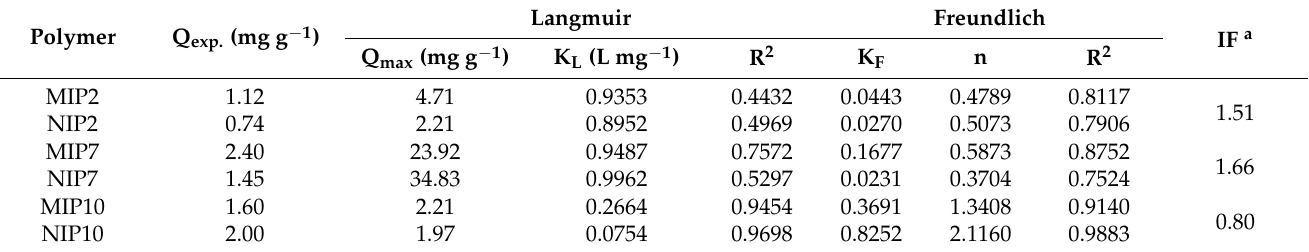
Table 2. Fitted results of adsorption data with Langmuir and Freundlich isotherm models using the non-linear method.